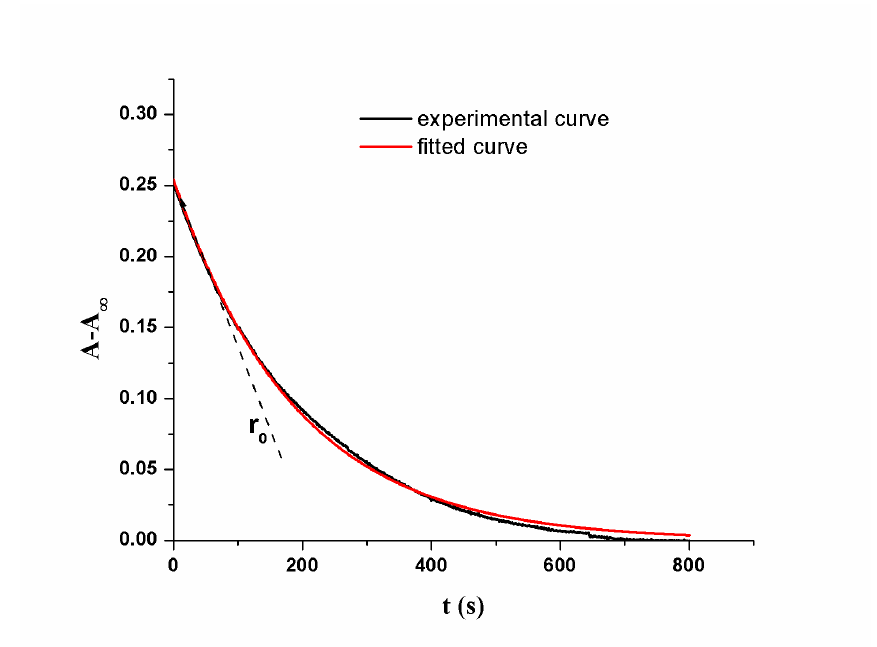
Fig. 1 A typical kinetic curve for the catalytic decomposition of H 2 O 2 in the presence of para – nitrophenol: [H 2 O 2 ] = 5 · 10 − 3 mol/L, [catalase] = 1 . 8 · 10 − 10 mol/L, [p – nitrophenol] = 4 · 10 − 6 mol/L pH = 7, at 20 ◦ C. “A” represents the absorbance of the reaction mixture at different moments and “A ∞ ” is the absorbance at the end of the